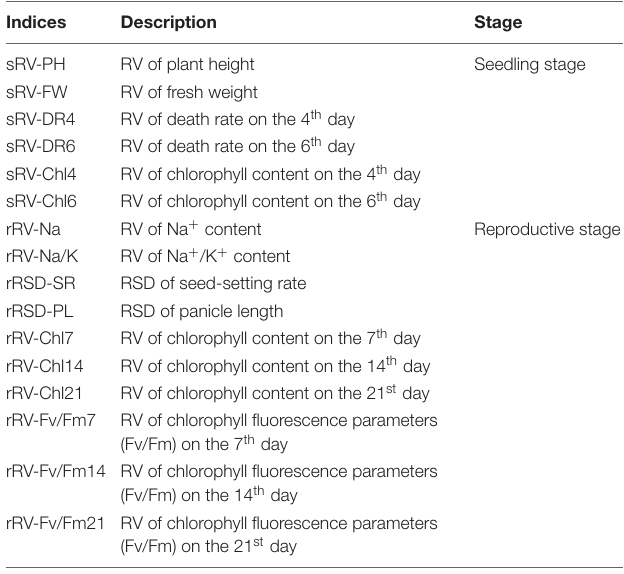
TABLE 2 | Details of salt tolerance (ST) related indices at the seedling stage and reproductive